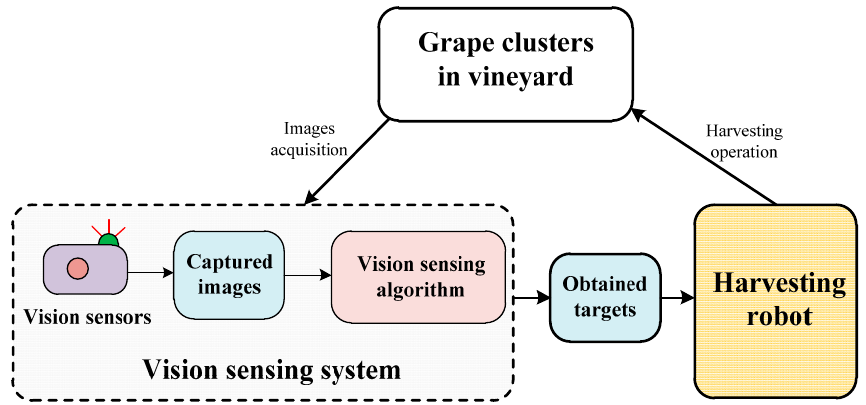
Figure 1. The vision sensing system of the harvesting robot.